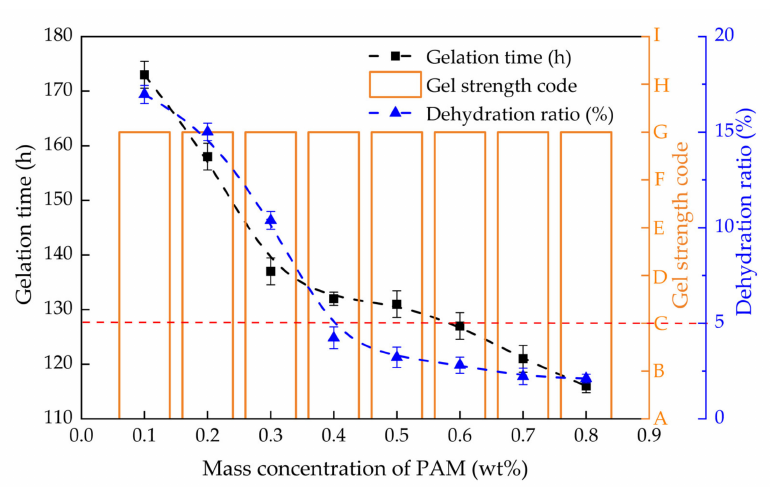
Figure 4. Gelling performance with different concentrations of PAM (0.5 wt% HMTA + 0.05 wt% RO + 0.3 wt%